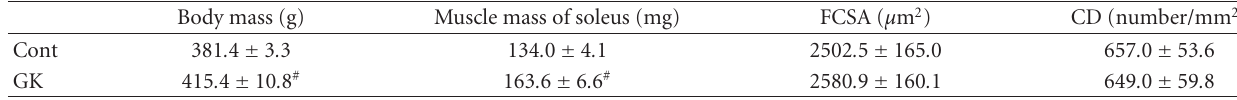
Table 1: Body and muscle parameter data in rats soleus.